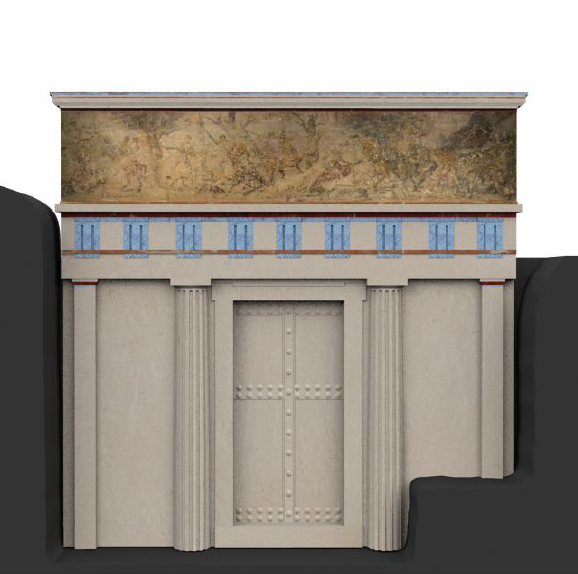
Figure 24. The Tomb of Philip II at Verghina. 3D model of the current state.